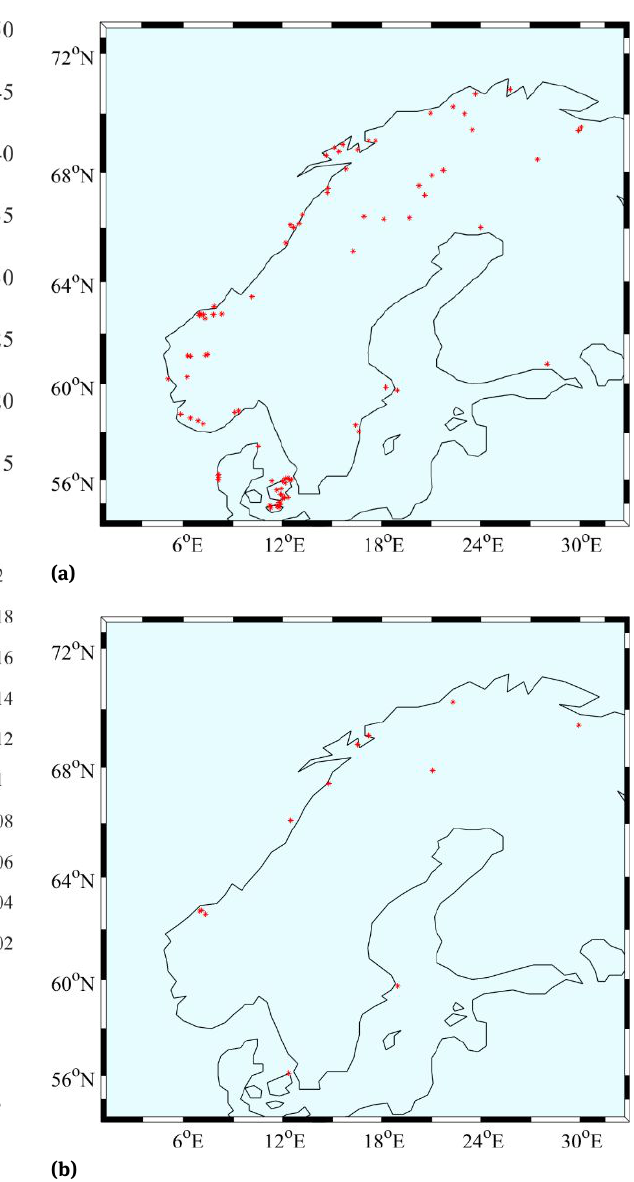
Fig. 2. a) GL outliers from filtering with a confidence interval of a) 95% and b)